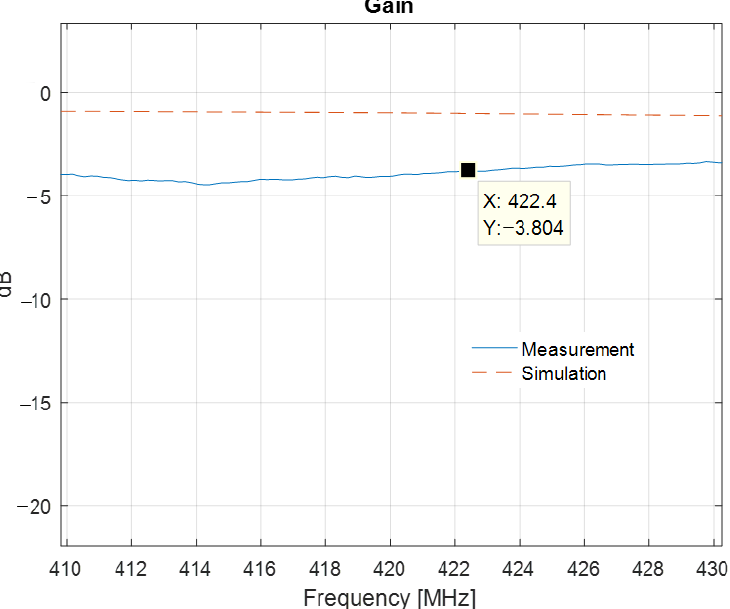
Figure 26. Gain of the printed meander line monopole antenna with an input impedance matching circuit: measured and simulated results.